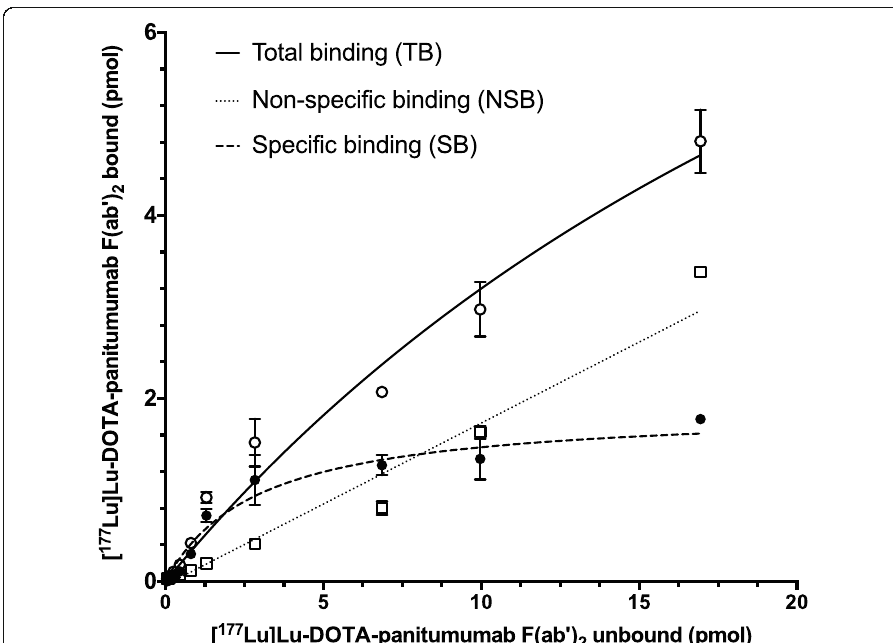
Fig. 2 Binding of [ 177 Lu]Lu-DOTA-panitumumab F(ab´) 2 to EGFR-overexpressing MDA-MB-468 human breast cancer cells in the absence (total binding; TB) or presence (non-specific binding; NSB) of an excess (2500 nmoles/L) of panitumumab IgG. Specific binding (SB) was calculated by subtracting NSB from TB. Curves were fitted to a one-site receptor binding model using Prism Ver. 4.0 software (GraphPad). Error bars represent the mean ± SD of duplicate samples. In the representative assay shown, K d = 2.9 ± 0.7 × 10 − 9 mol/ L and B max = 1.1 ± 0.1 × 10 6